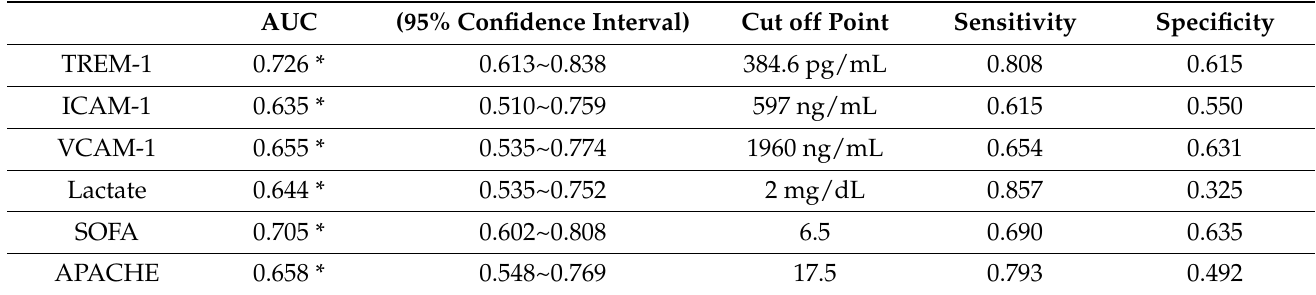
Table 4. ROC curve analysis of different biomarkers or score in predicting sepsis-related fatality.